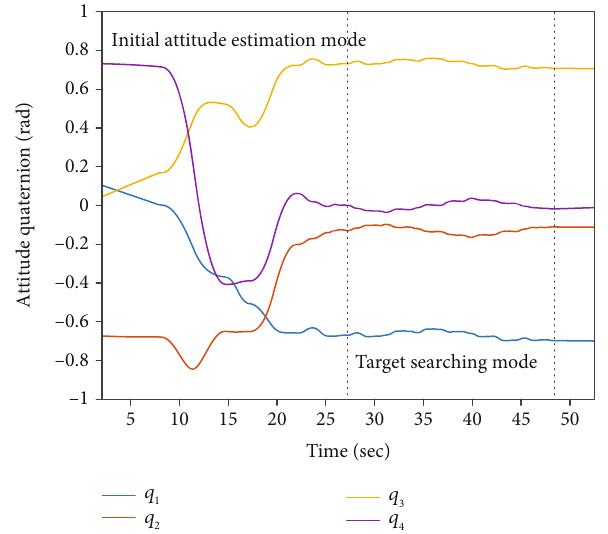
Figure 11: Time history of attitude quaternion during initial attitude estimation mode and target searching mode. Table 1: Total mission time of both initial attitude estimation mode and target searching mode in di ff erent initial condition settings. Initial disturbance